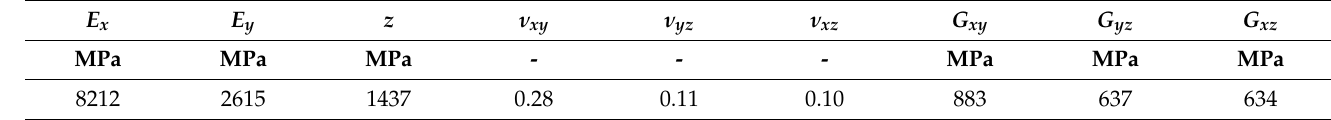
Table 1. Material parameters determined from experiments, rounded.